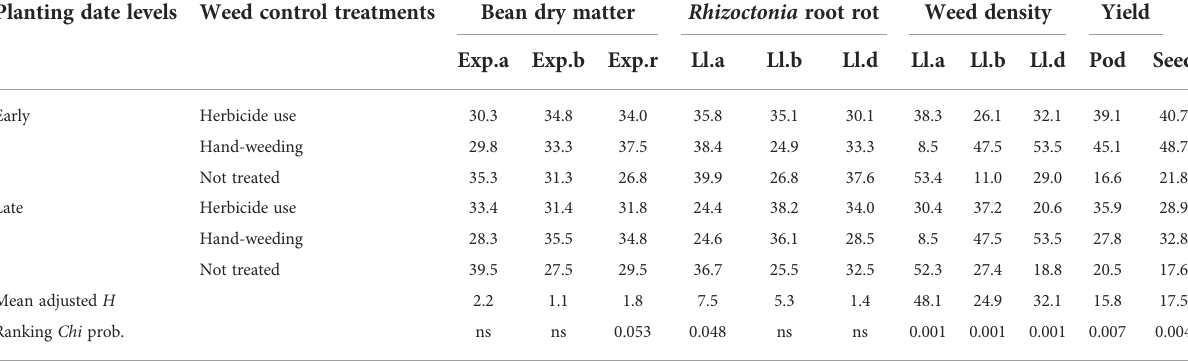
TABLE 3 Analysis of development of bean dry matter, Rhizoctonia root rot incidence, and weed density using Kruskal-Wallis one-way ANOVA for bean cultivars grown under different planting date and weed control treatments. Planting date levels Weed control treatments